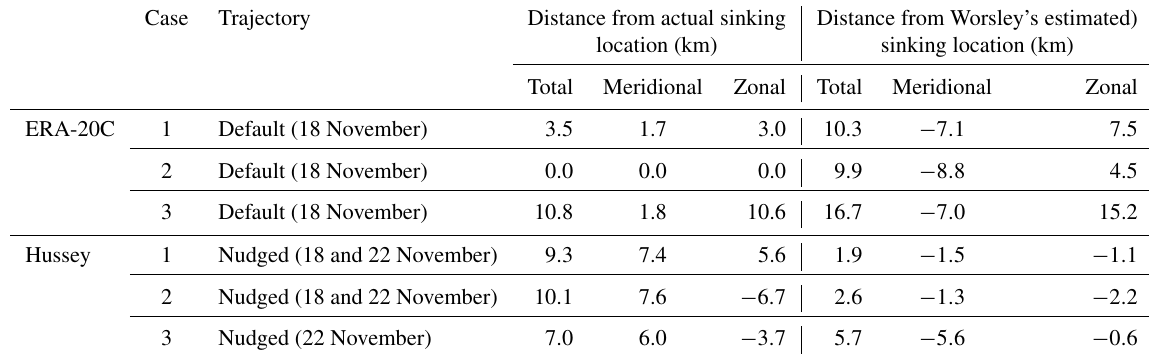
Table 1. Total and vector component distances from the various simulated sinking locations to the actual sinking locations as well as to Worsley’s estimated sinking location. Negative meridional (zonal) values indicate offsets to the south (west) of the reference.